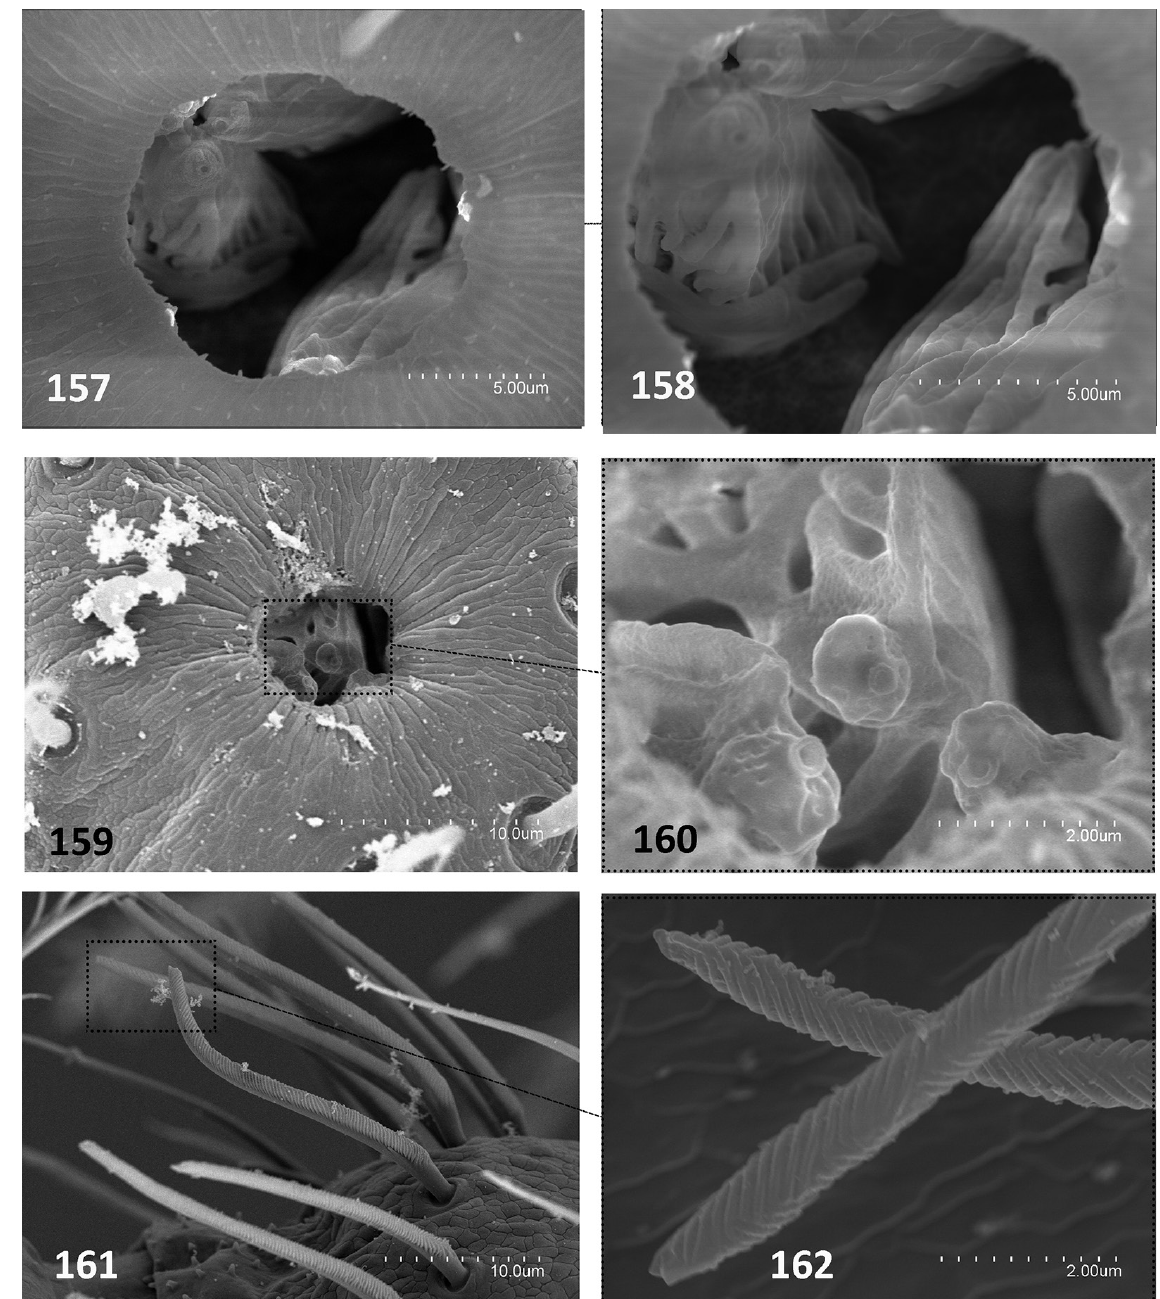
Figs 157–162. Plusiocampa ( Stygiocampa ) nivea (Joseph, 1882), from Habečkov Brezen, Idrijski Log Idrija, Slovenia (157–158), Velika ledena jama v Paradani, Predmeja, Slovenia (159–160, 162) and Volčja jama, Postojna, Slovenia (161) (Coll. AS). 157 . Cupuliform organ. 158 . Olfactory chemoreceptors. 159 . Cupuliform organ. 160 . Olfactory chemoreceptors. 161 . Lateral distal portion of a medial antennomere. 162 . Distal portion of two gouge